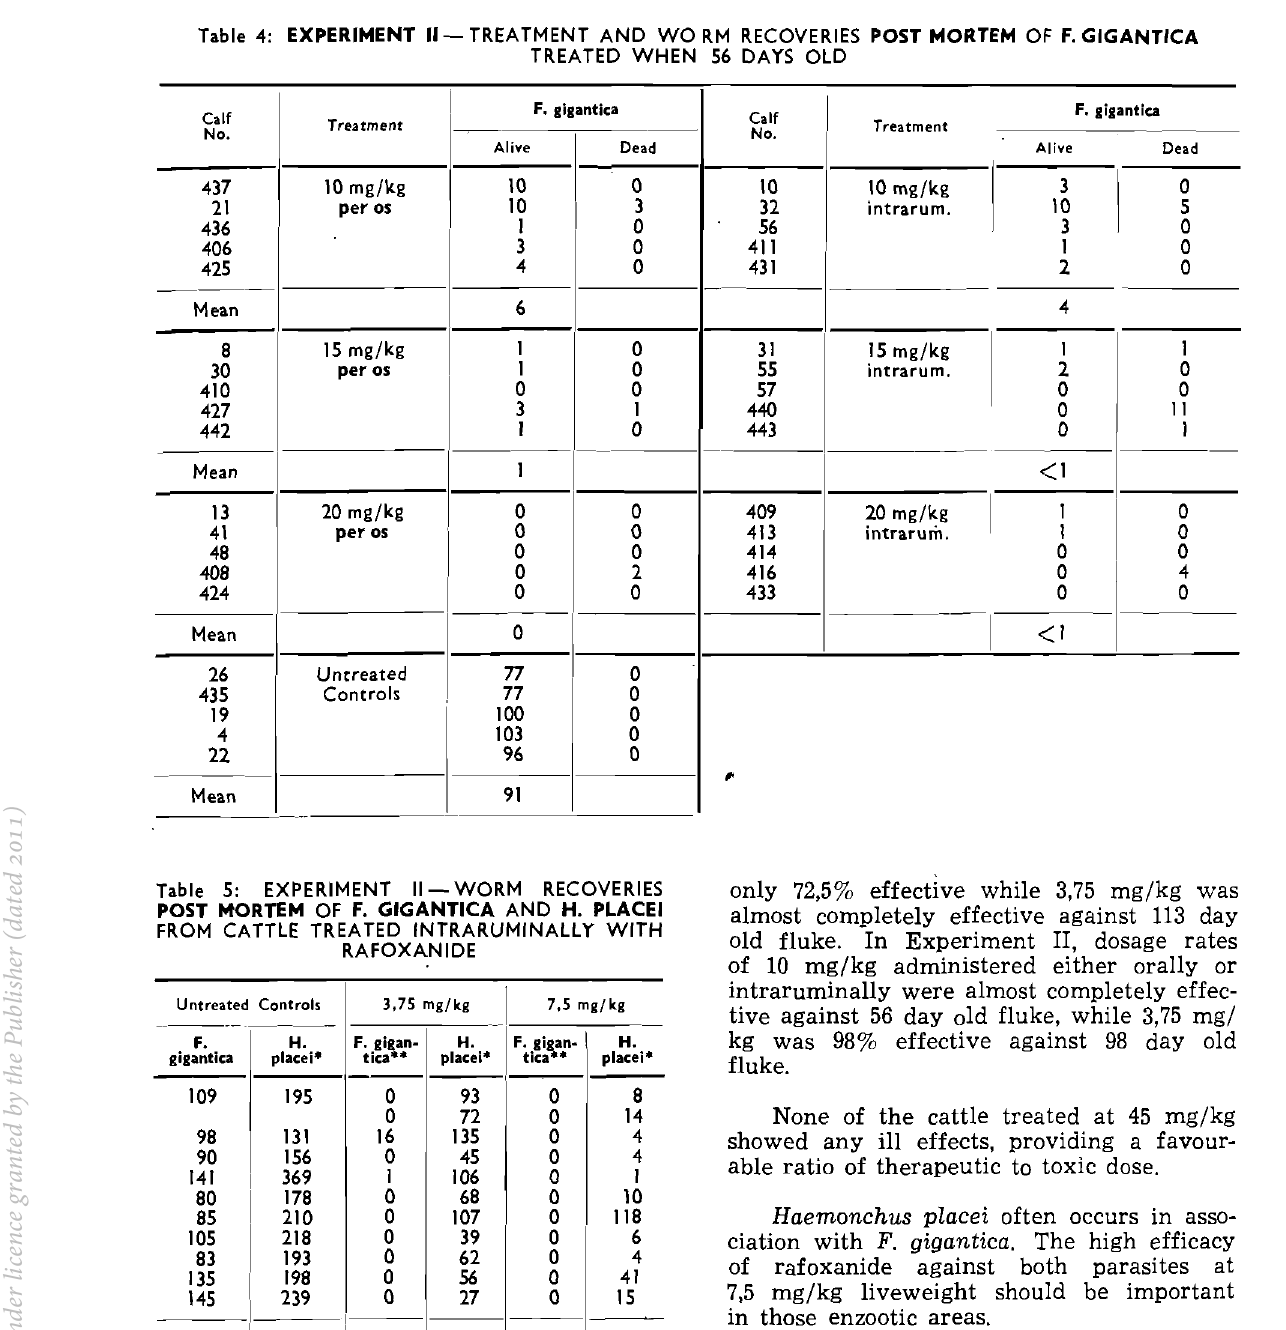
% Re- 98 *Fourth stage larvae and adult worms **98 Days old at treatment